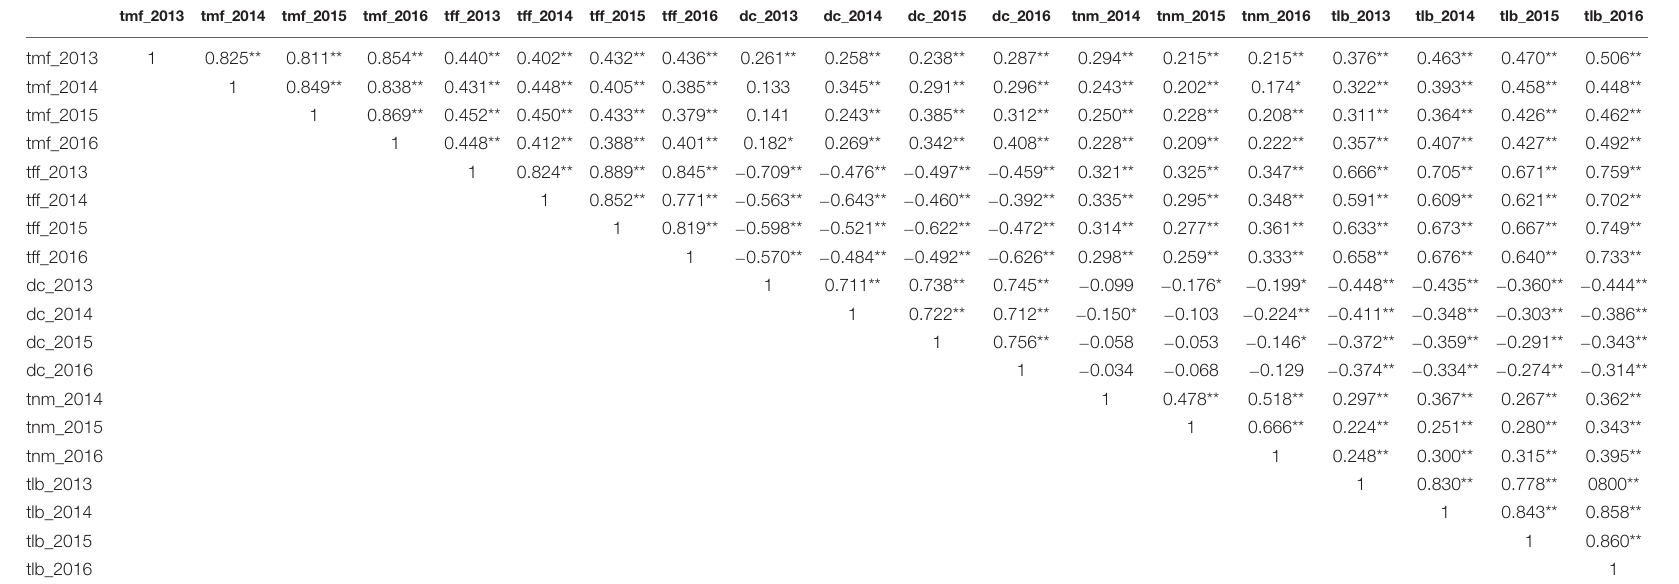
The tlb data are taken from Torello Marinoni et al. (2018). *Correlation is significant at 0.05 level (two-tailed). **Correlation is significant at 0.01 level